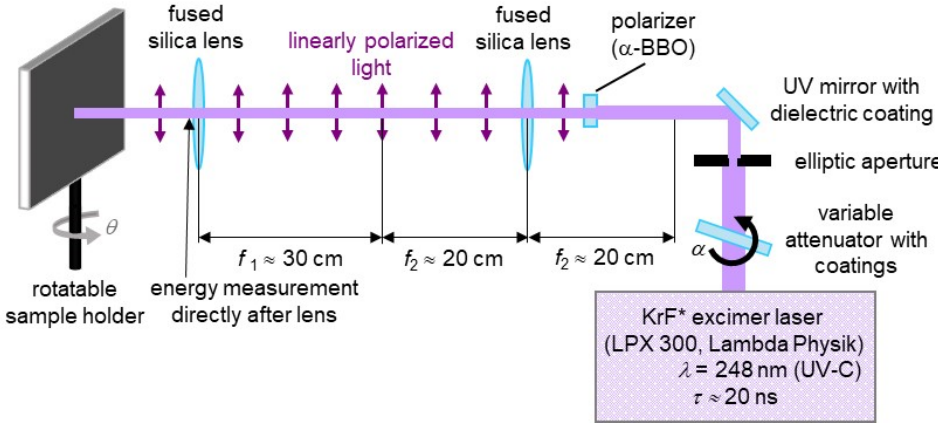
Figure 3. Schematic of the used KrF* excimer laser setup for the production of nanoripples on PET foils. Adapted from ref. [41].